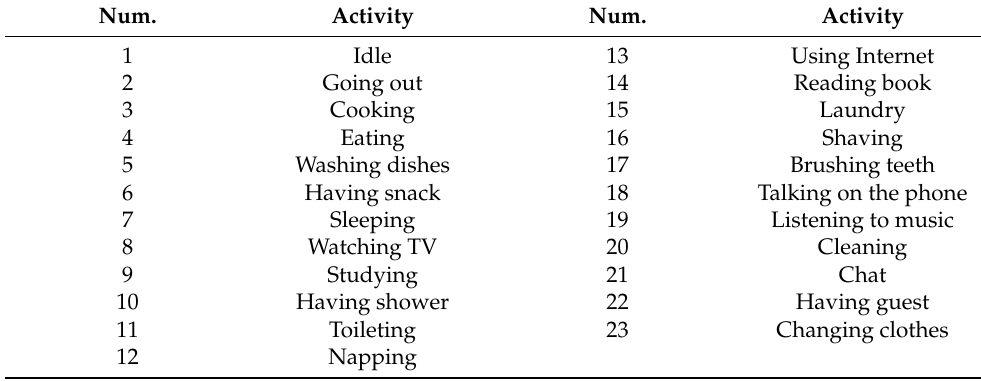
Table 6. Combined